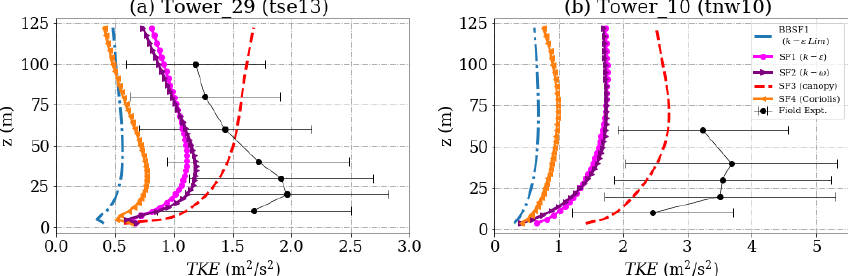
Figure 17. Simulation results and experimental data for turbulent kinetic energy on the northeast ridge for (a) Tower 29 (tse13) and (b) Tower 10 (tnw10). The locations of the masts are given in Fig. 2.